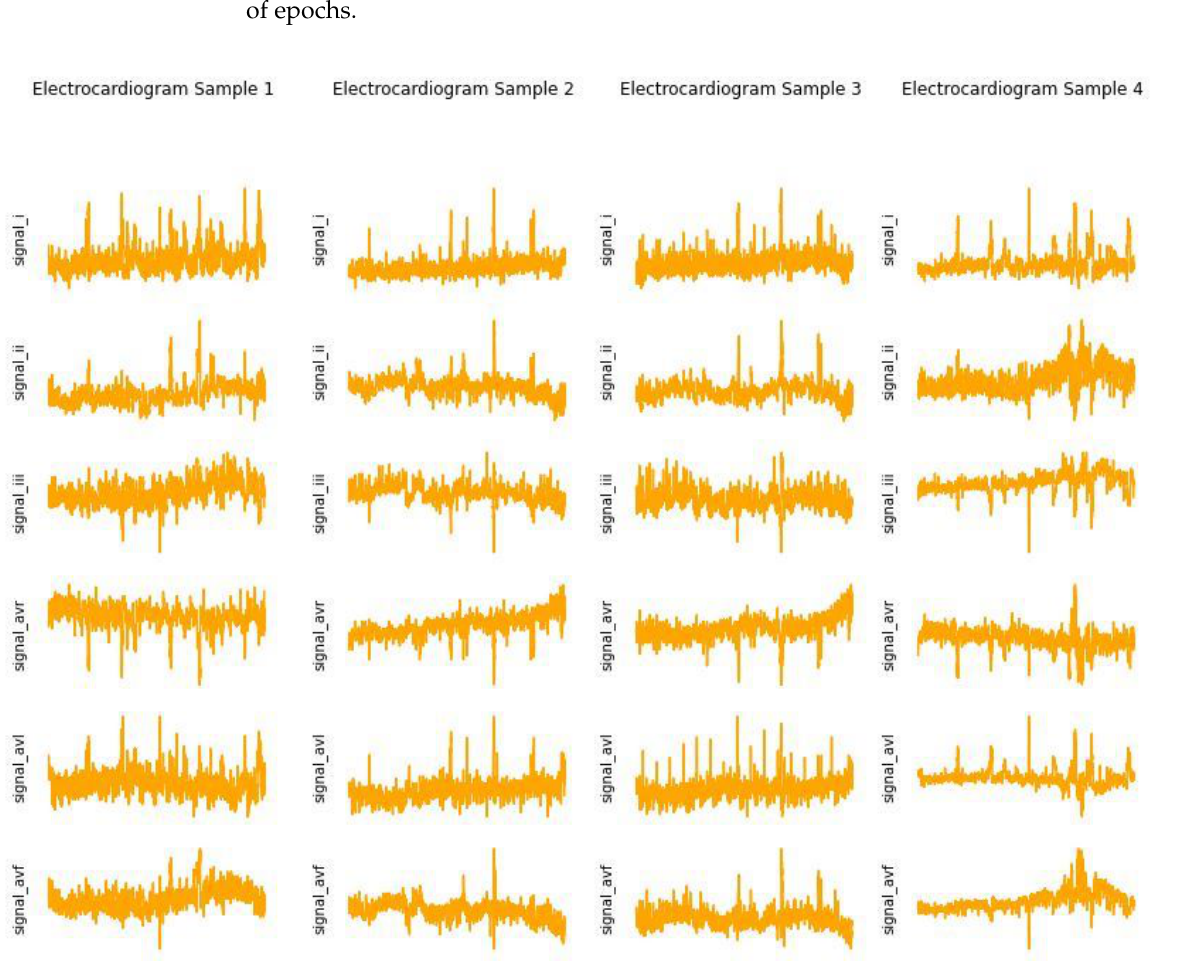
Figure 18. Generated electrocardiograms for the